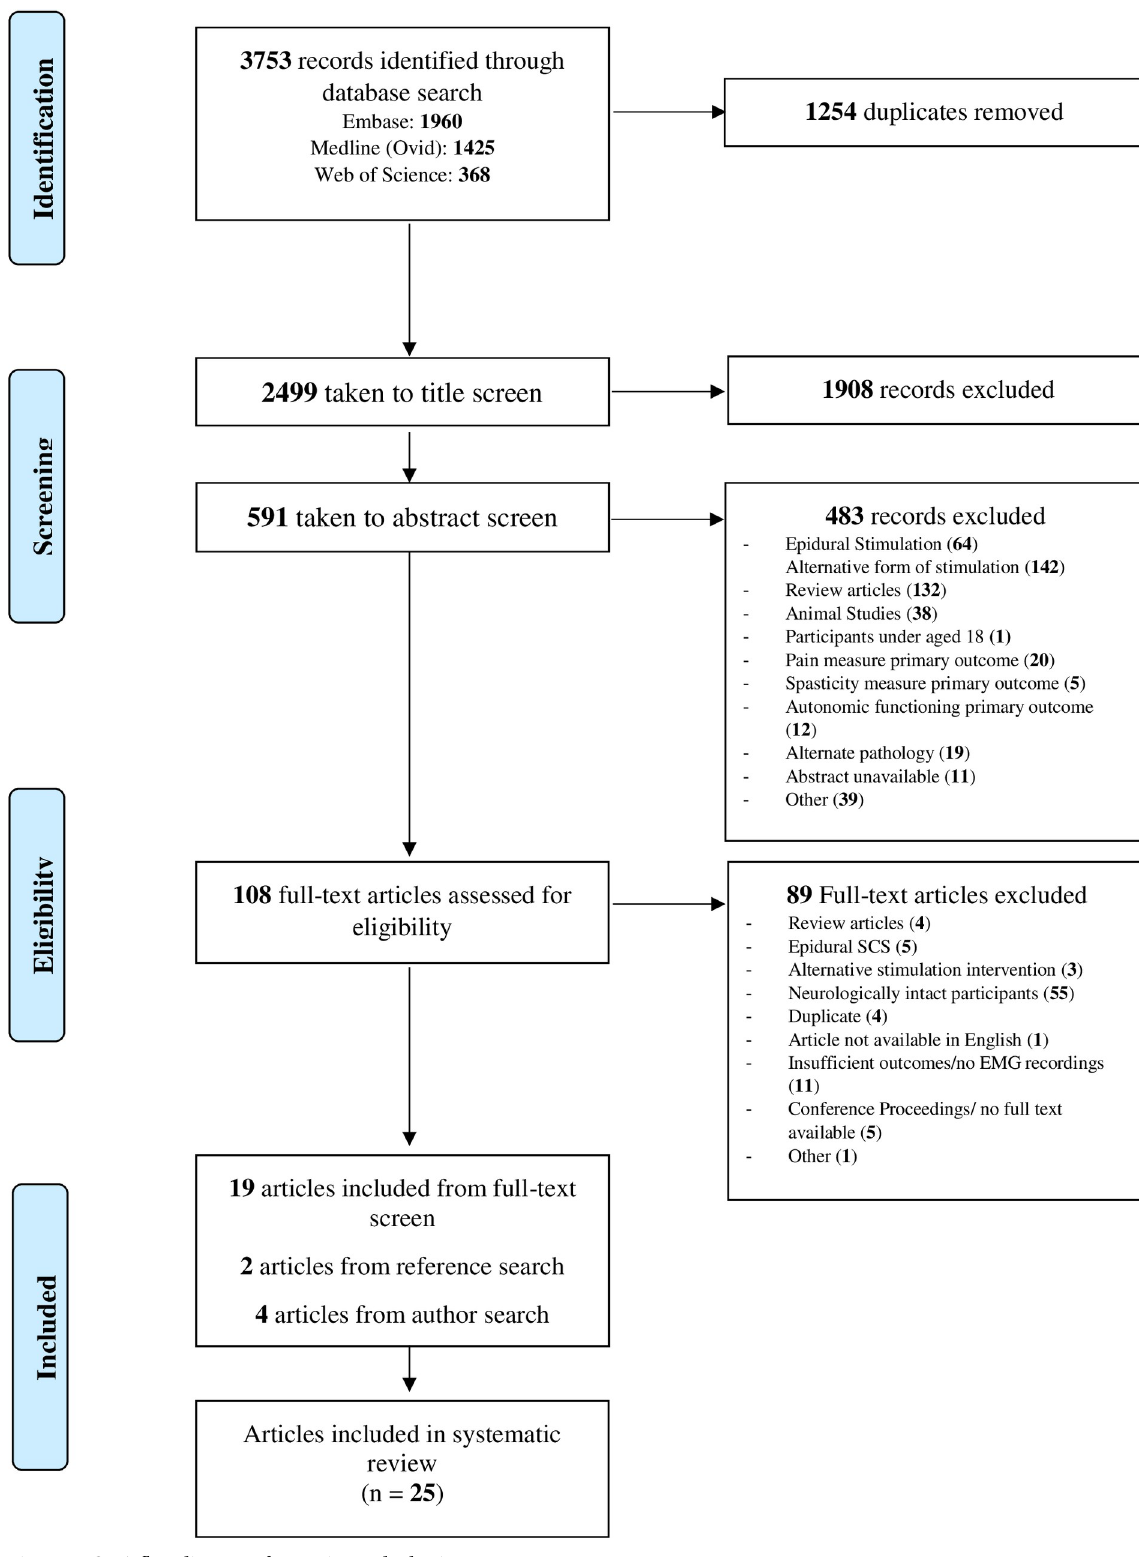
PLOS ONE | https://doi.org/10.1371/journal.pone.0260166 November18,